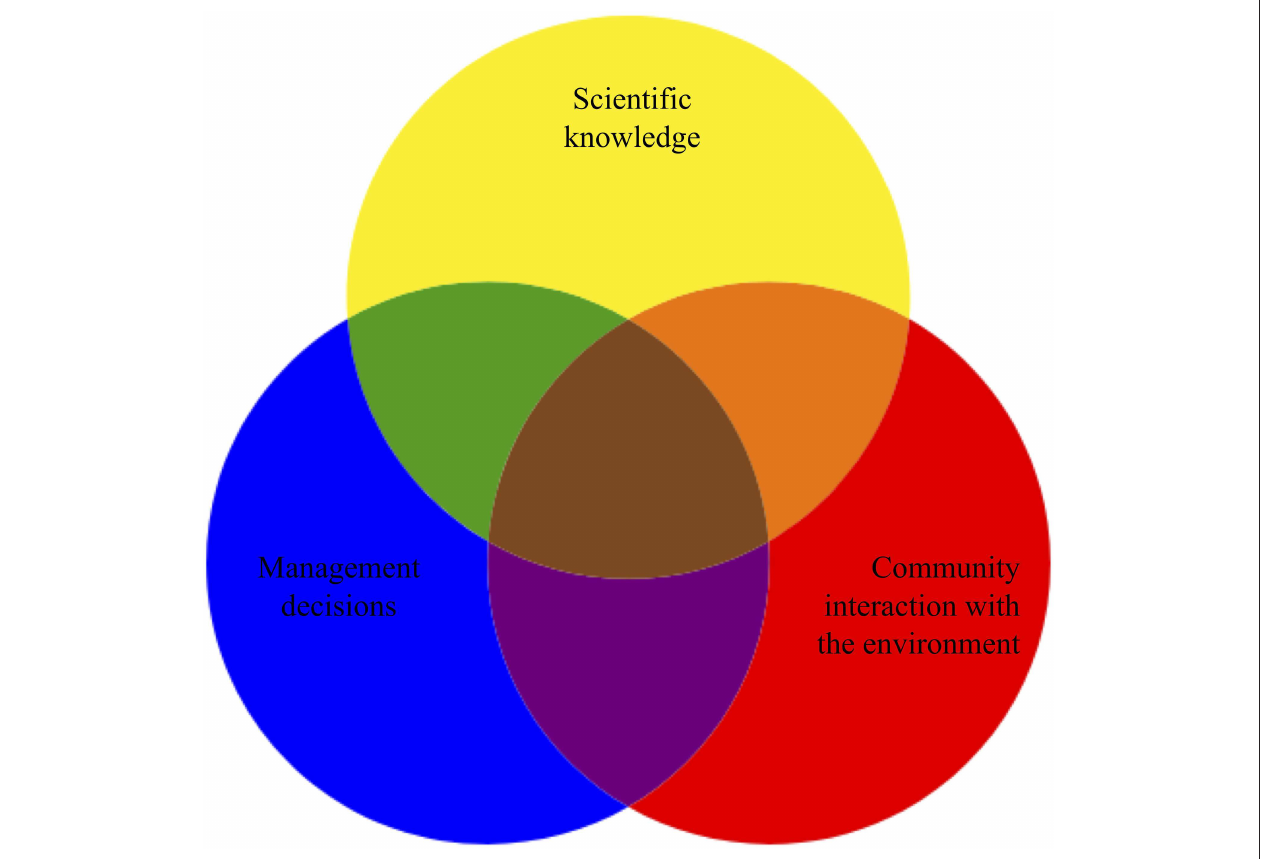
FIGURE 1 | PUGS management using the three components. The intersection of the three circles is in which elements of a proper management should arise.